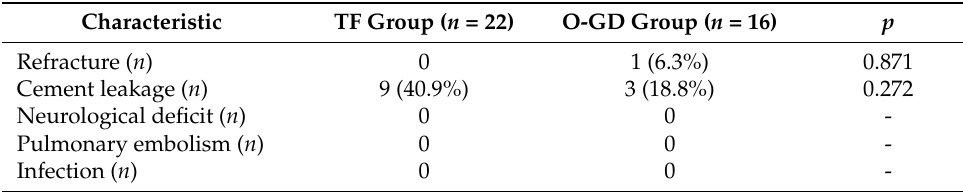
Table 4. Comparison of complications between the 2